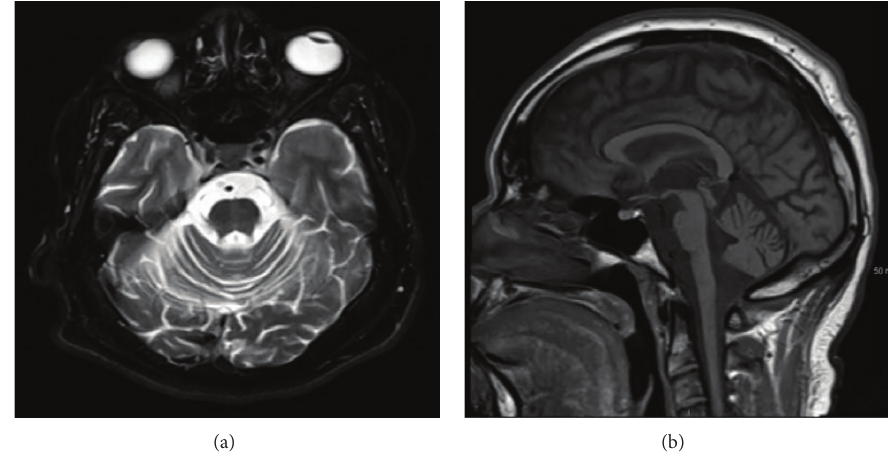
Figure 2: MRI of IV:10, an axial T2 on the left and sagittal FLAIR on the right, demonstrating pontine and cerebellar